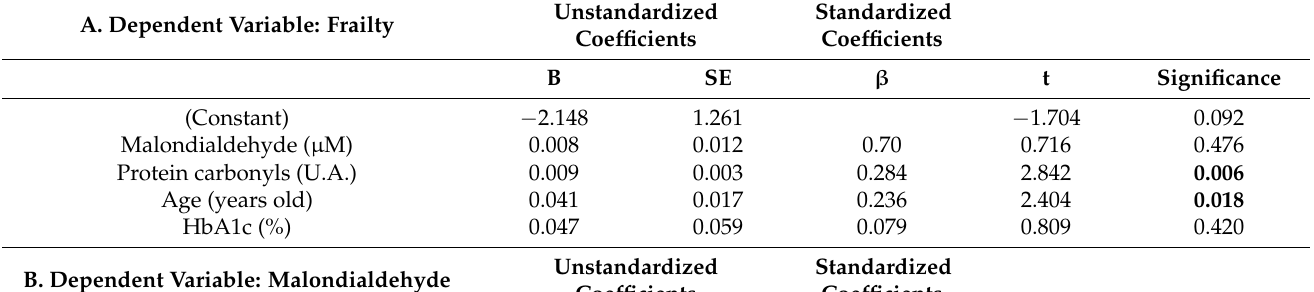
Table 4. Linear regression analysis for frailty ( A ) and oxidative stress parameters (malondialdehyde ( B ) and protein carbonyls ( C